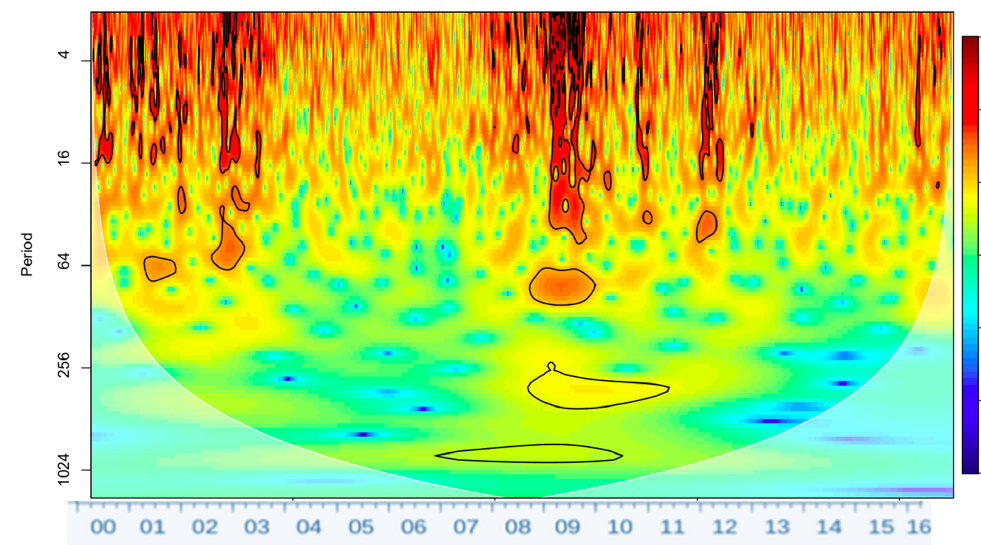
Figure 1. Wavelet Power Spectrum for the U.S.